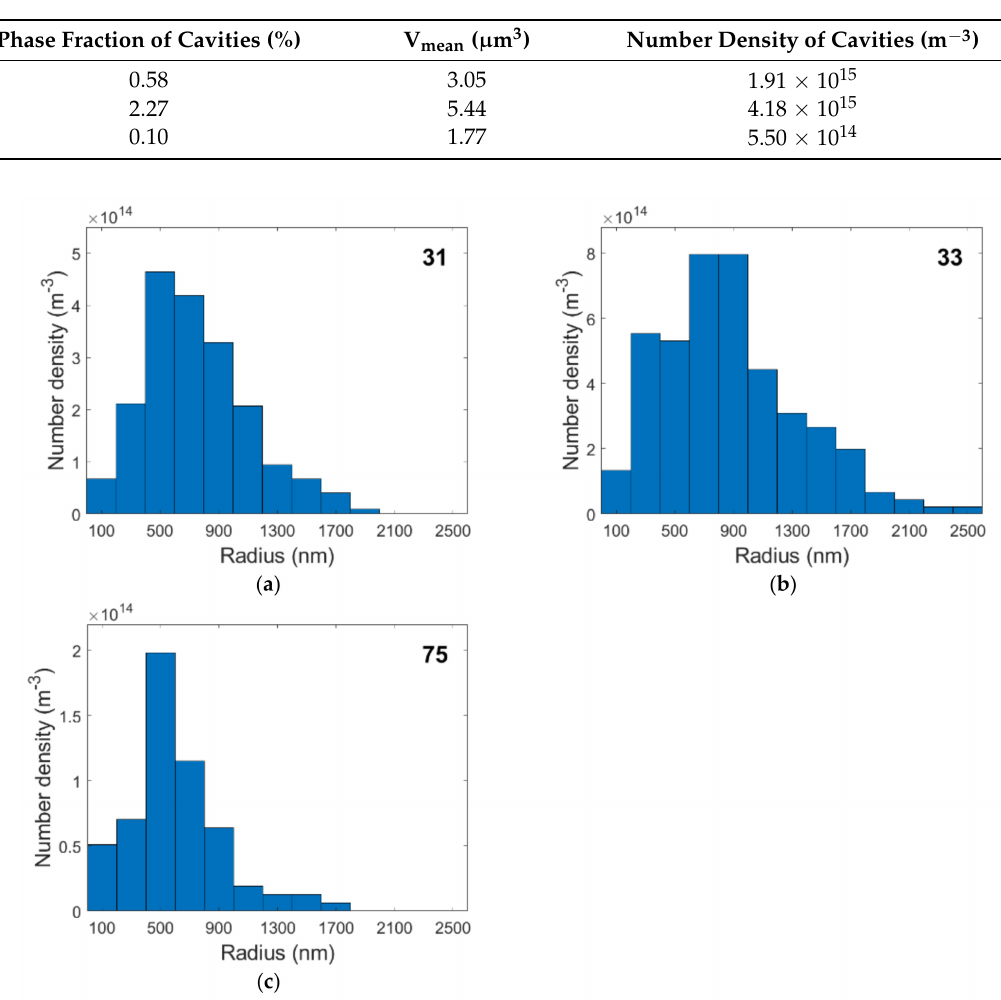
Figure 6. Cavity radii vs. number density in specimens 31 ( a ), 33 ( b ), and 75 ( c ).